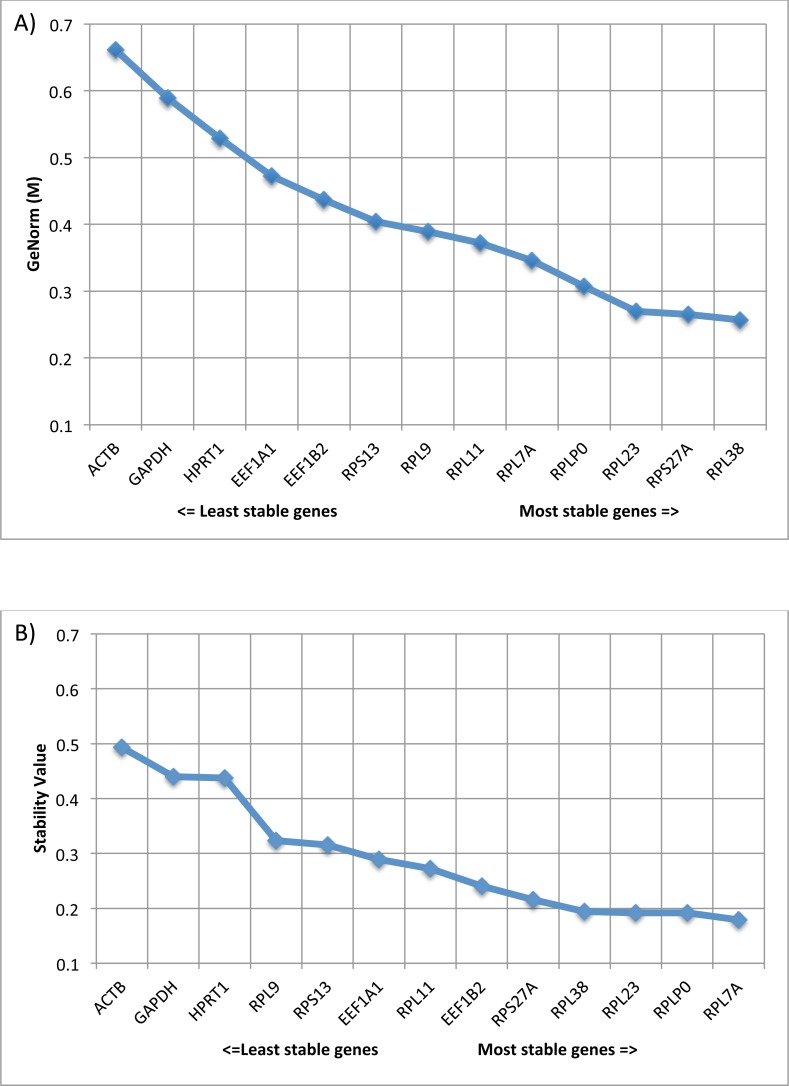
Comparison of expression stability using GeNorm and Normfinder.(A) Average expression stability of reference targets (geNorm). geNorm M value, an indicator of gene expression stability, was determined using the geNorm algorithm. Decreasing values correlate with smaller variations in gene expression levels across lesion groups AK, SCC, SK, BCC, IEC, and healthy skin. (B) Average expression stability of reference targets (Normfinder). Stability values were determined for each gene using the Normfinder algorithm. Decreasing values correlate with smaller variations in gene expression levels across lesion groups AK, SCC, SK, BCC, IEC, and healthy skin.